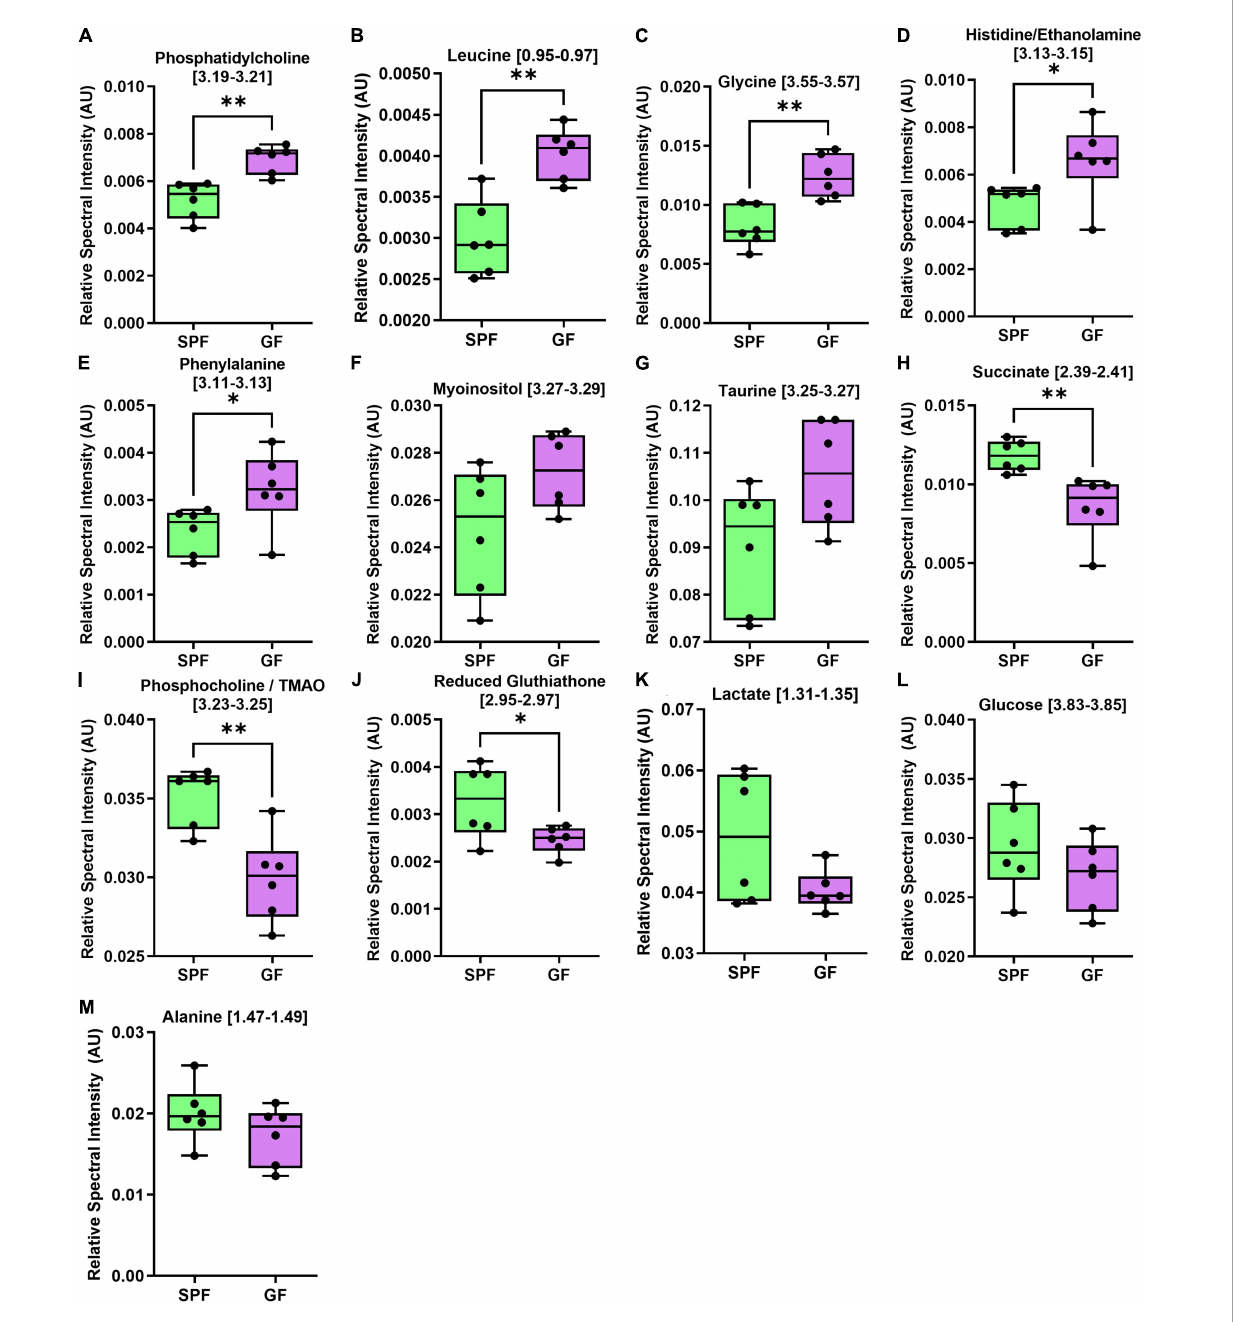
FIGURE5 The liver metabolome is altered in GF ( n = 7) compared to SPF ( n = 5) mice. Boxplots represent the interquartile range (IQR), and whiskers display minimum/maximum values. (A) Phosphatidylcholine ( p = 0.0015 ∗∗ ), (B) leucine ( p = 0.0010 ∗∗ ), (C) glycine ( p = 0.0019 ∗∗ ), (D) histidine/ethanolamine ( p = 0.0327 ∗ ), and (E) phenylalanine ( p = 0.0451 ∗ ) were all significantly increased in GF. (F) Myoinositol ( p = 0.0532) and (G) taurine ( p = 0.0812) were increased in GF. (H) Succinate ( p = 0.0057 ∗∗ ), (I) phosphocholine/TMAO ( p = 0.0030 ∗∗ ), and (J) reduced glutathione ( p = 0.0499 ∗ ) were significantly decreased in GF. (K) Lactate ( p = 0.1012), (L) glucose ( p = 0.2489), and (M) alanine ( p = 0.2156) were not significantly different between